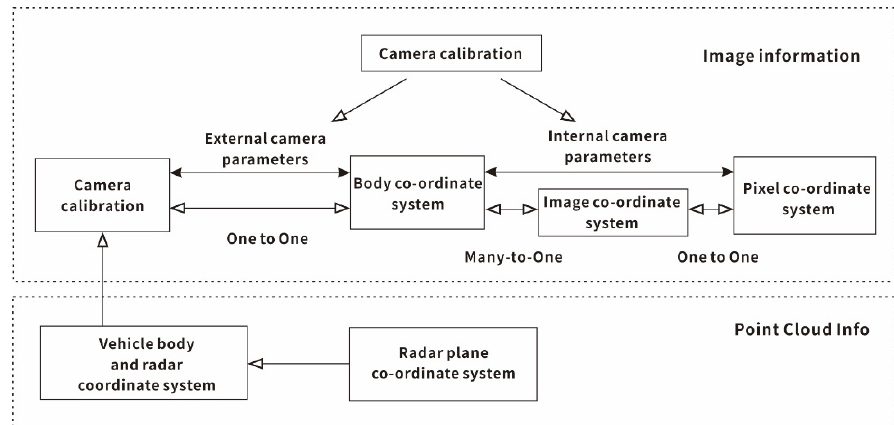
Figure 3. Diagram of coordinate system conversion.